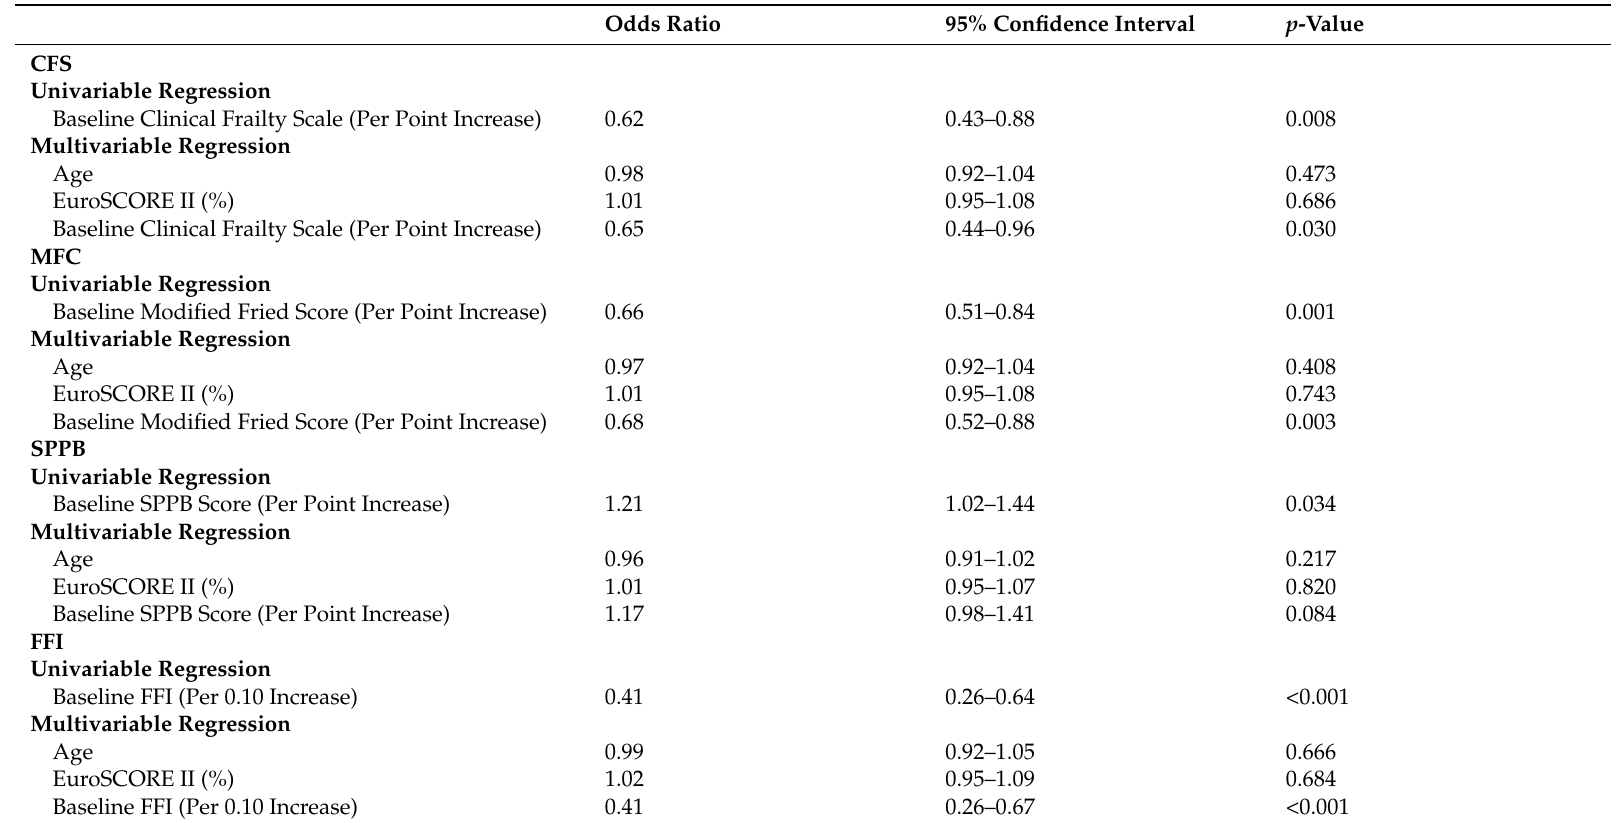
Table A2. Baseline frailty measures as a predictor of CR